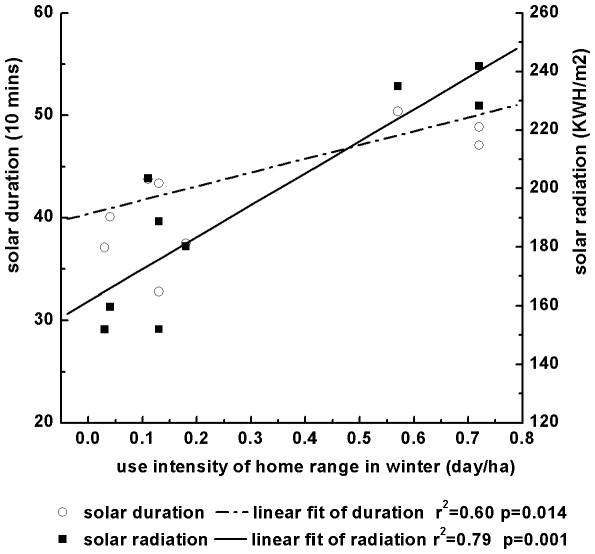
Relationship between range use intensity (days/ha) and sunshine duration and radiation within the winter range (mainly 4100–4400 m).